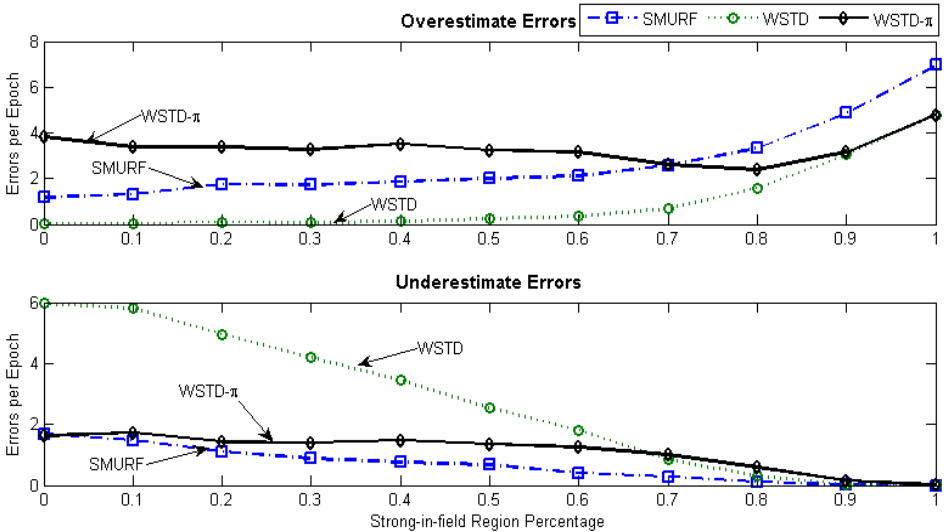
Figure 21. Variable window schemes’ average overestimate and underestimate error contributions as the StrongPercentage parameter is varied with each tag moving with its own